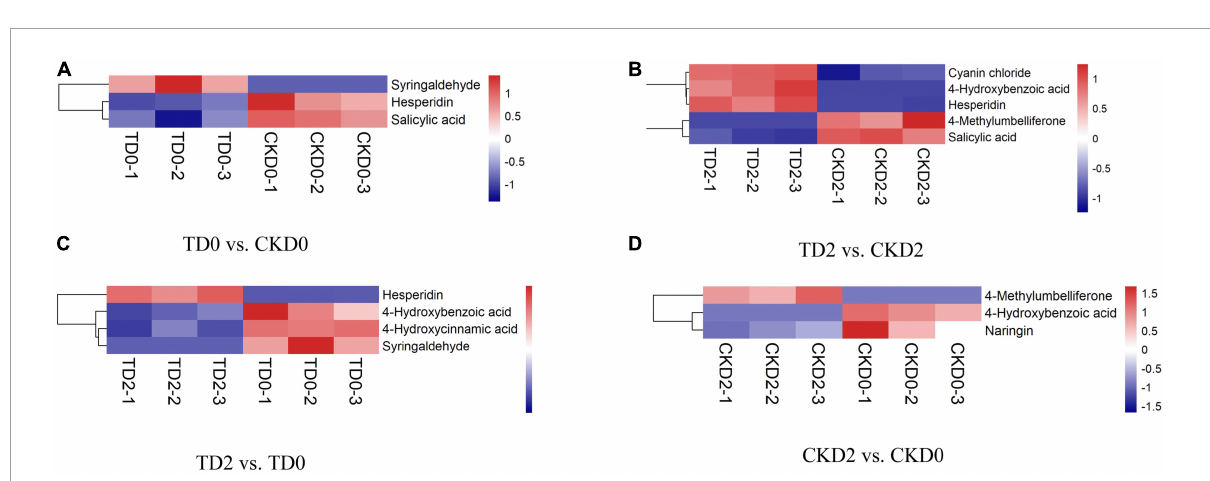
FIGURE5 Hierarchical clustering analysis of the differential metabolites, including TD0 vs. CKD0 (A) , TD2 vs. CKD2 (B) , TD2 vs. TD0 (C) , and CKD2 vs. CKD0 (D) . Red indicates significant upregulation of metabolites, and blue indicates significant downregulation of metabolites.